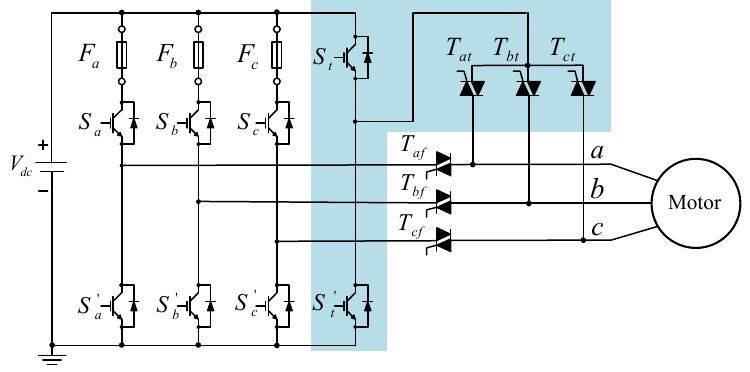
Figure 1. Fault-tolerant inverter.